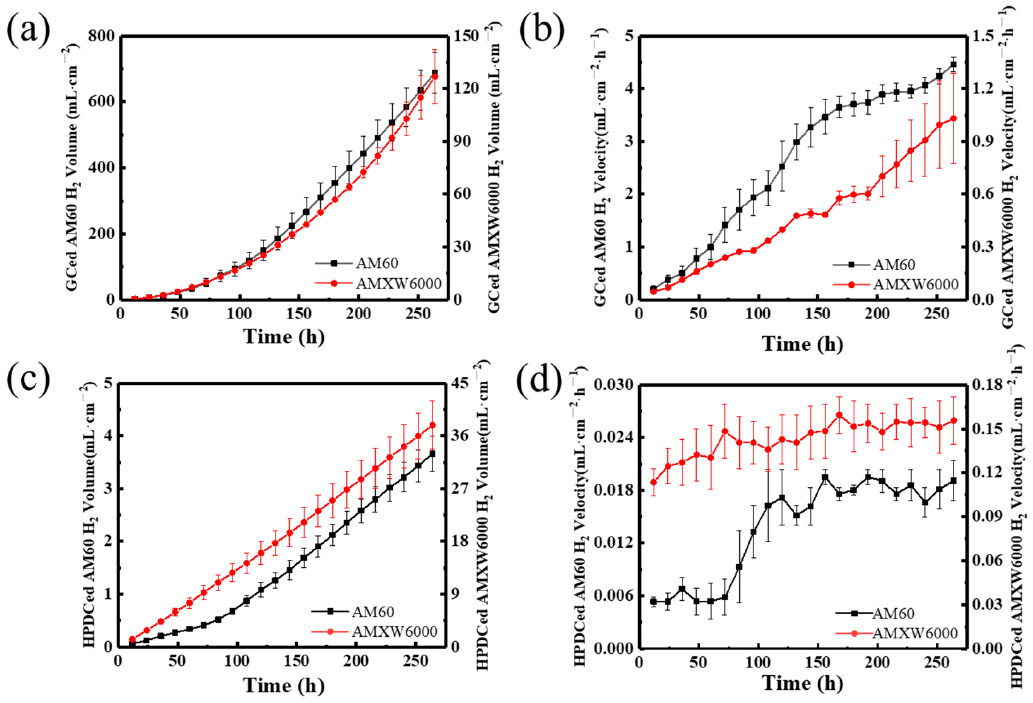
Figure 8. H 2 release volume ( a , c ) and calculated evolution rate ( b , d ) of AM60 and AMXW6000 alloy in terms of time in GC and HPDC state, respectively.